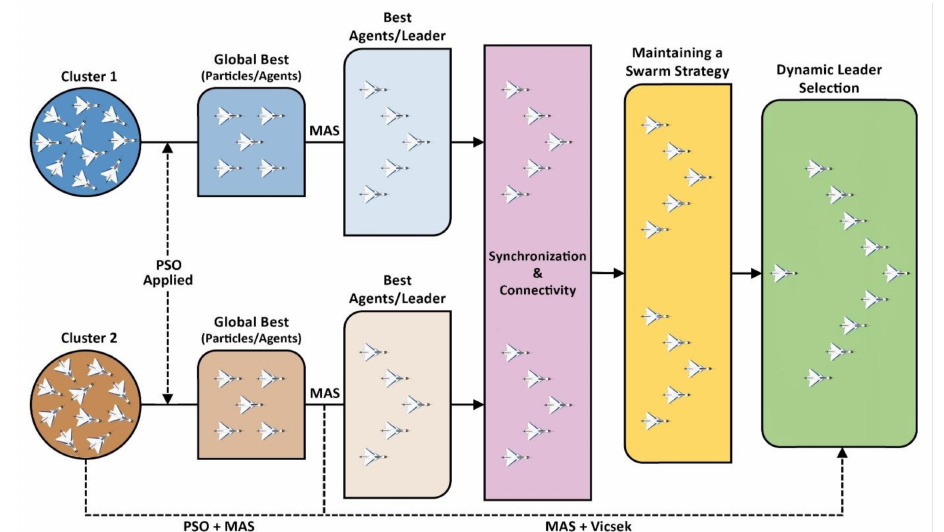
Figure 3. The architecture of the proposed